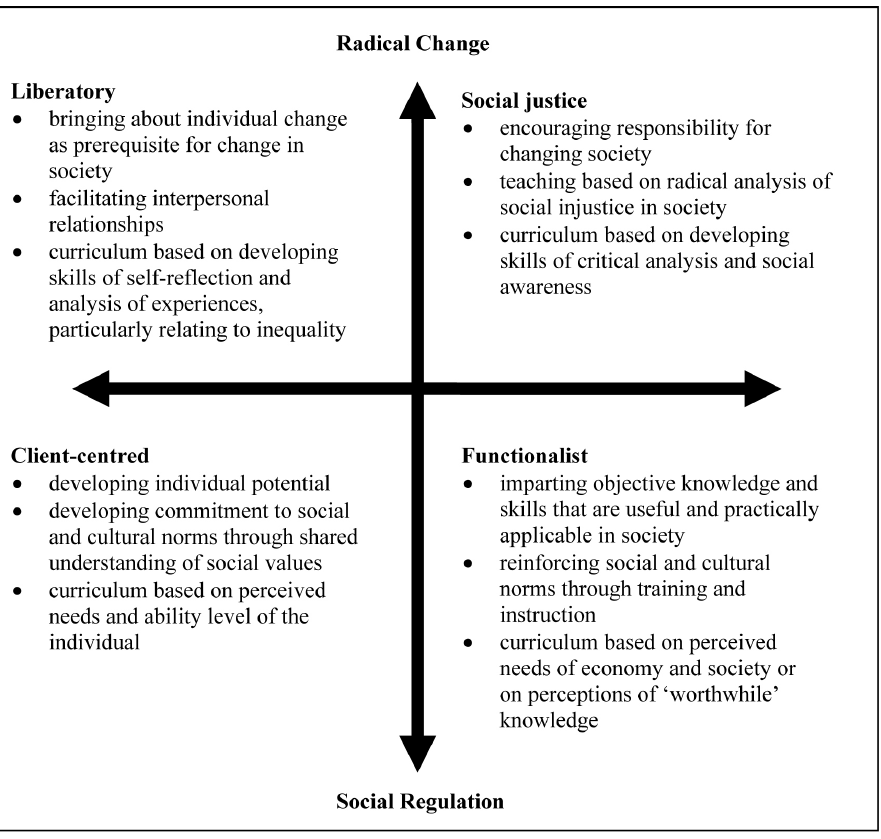
Figure 1: Askew and Carnell’s typology of models of